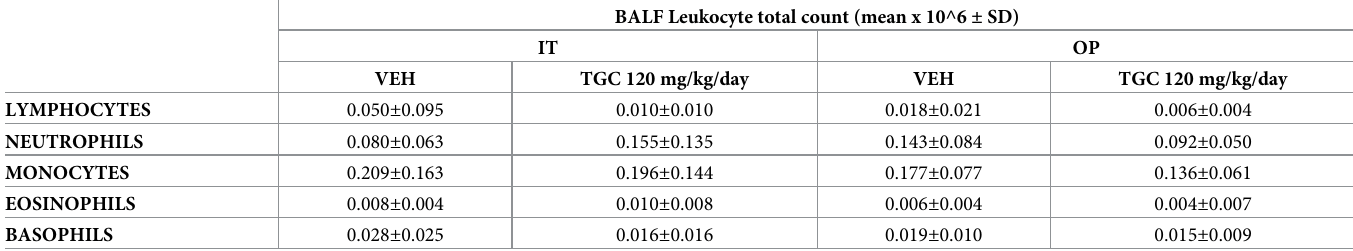
Table 7. BALF leukocytes total